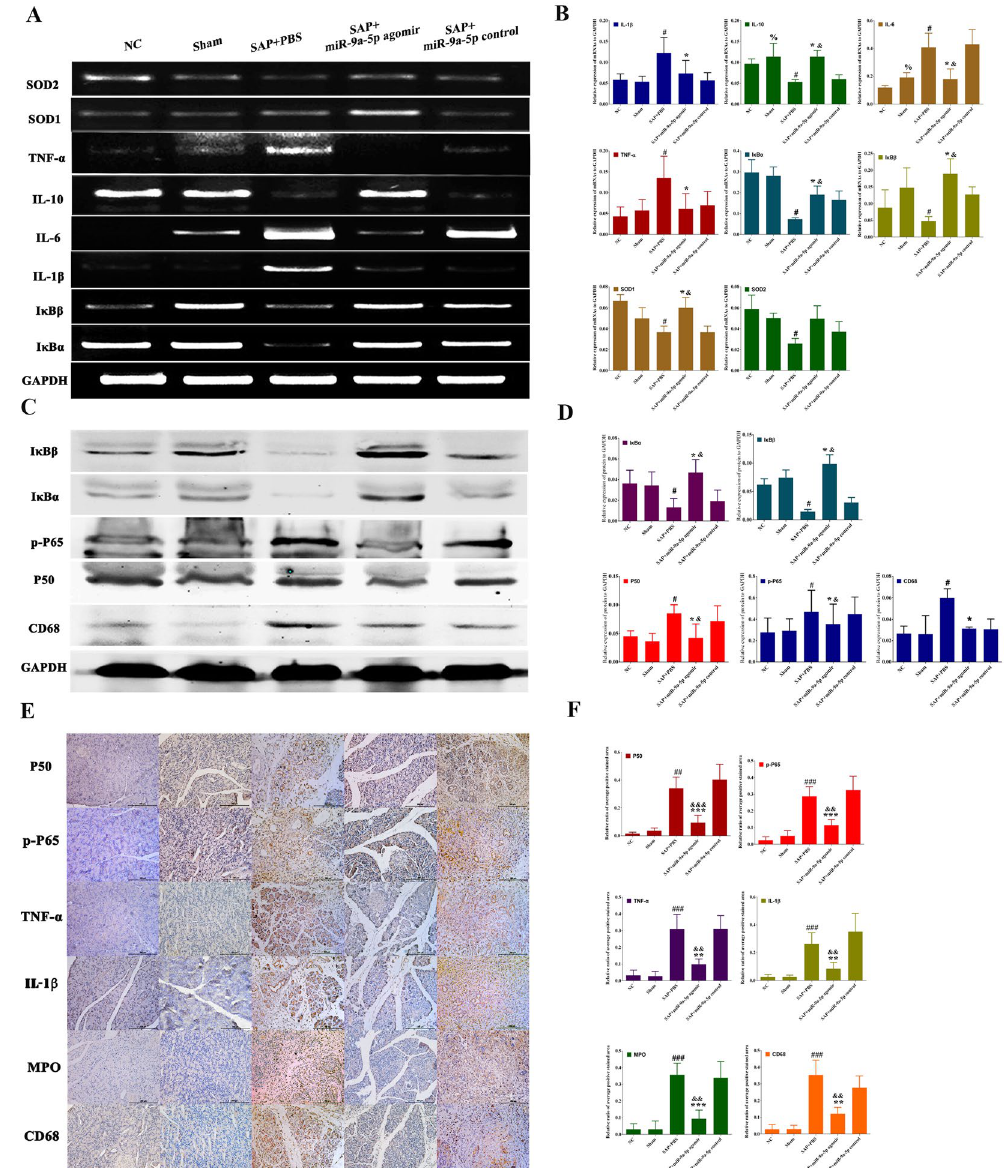
Figure 4. miR-9 could antagonize the local inflammatory response. The expressions of IL-1 β , IL-6, TNF- α , MPO, p-P65, P50, and CD68 were significantly decreased by miR-9a-5p agomir. Inversely, the expressions of SOD 1 , SOD 2 , I κ B α , and I κ B β were significantly increased by miR-9a-5p agomir, compared with SAP + PBS or miR-9a-5p control group, by gPCR ( A,B ), Western-blot ( C,D ) and IHC ( E,F ). Data are shown as mean ± SD for at least 3 separate experiments. % P < 0.05, compared with NC, # p < 0.05 and ### p < 0.001, compared with NC, * p < 0.05, ** p < 0.01 and *** p < 0.001, compared with SAP + PBS, & p < 0.05, && p < 0.01, and &&& p < 0.001, compared with miR-9a-5p control by using paired t test. SOD, Superoxide Dismutase, gPCR, General PCR, IHC,